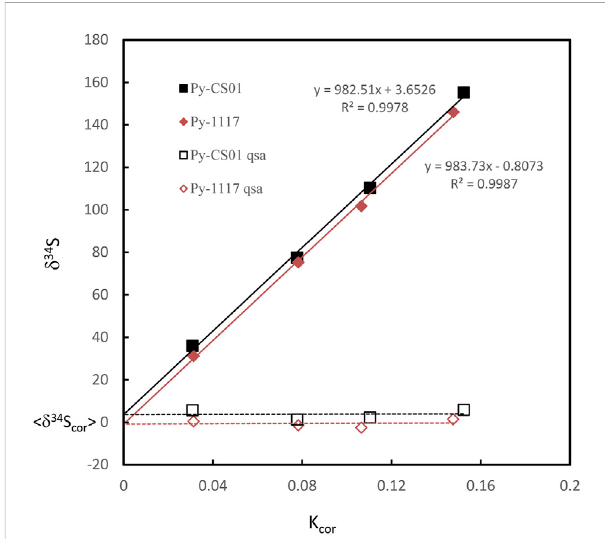
FIGURE 3 The plot of the relation between δ 34S and Kcor before and after QSA correction. The QSA coef fi cient β (slope) of ~ 0.98 is determined. The slope is consistent within the fi tting error in these two pyrite standardsondifferentSisotopiccompositions.Thegapbetween the fi ttinglineinterceptindicatesthedifferenceinthecompositionsof the S